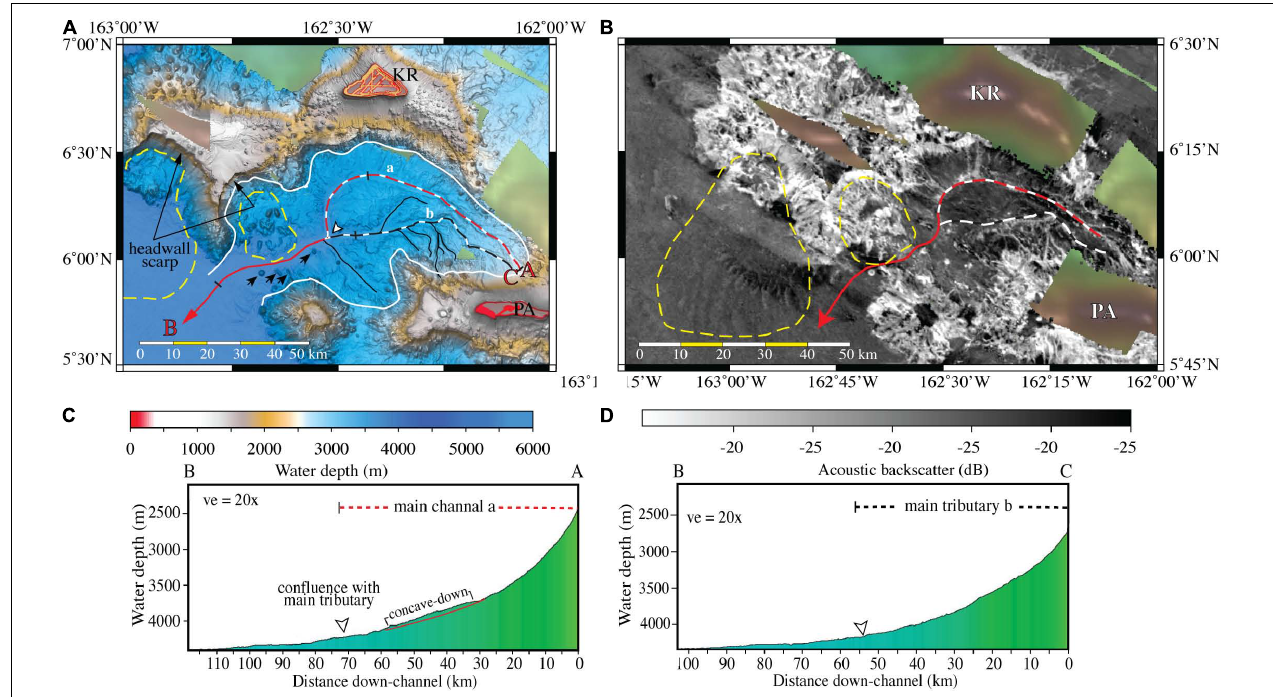
FIGURE 9 | Map views of multibeam bathymetry (A) and acoustic backscatter (B) of channel system CS-B (see Supplementary Figure S4 for same view of bathymetry with no interpretations). Location of CS-B shown on Figure 3 . Drainage area (see text) outlined in white. The upper main channel shown as a red and white dashed line labeled “a” and the lower main channel in solid red line. A major tributary is shown as a black and white dashed line labeled “b”. Tributaries are shown as solid black lines. Fifty kilometer distance markers on main channel are black lines across the channel. The down-channel profile of the main channel is labeled A–B and shown in (C) . The major tributary channel “b” is shown as a black and white dashed line and the channel profile B–C is shown in (D) . White arrowhead shows location of the confluence of the main channel and the major tributary channel. Minor tributary channels are shown as solid black lines. Yellow dashed lines enclose landslide deposits. Black arrows may be landslide blocks. KR is location of Kingman reef and PA is location of Palmyra